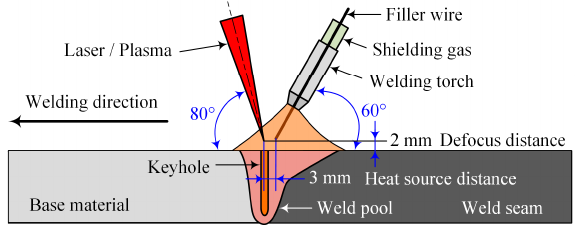
Figure 2. Schematic diagram of laser-MIG hybrid welding.